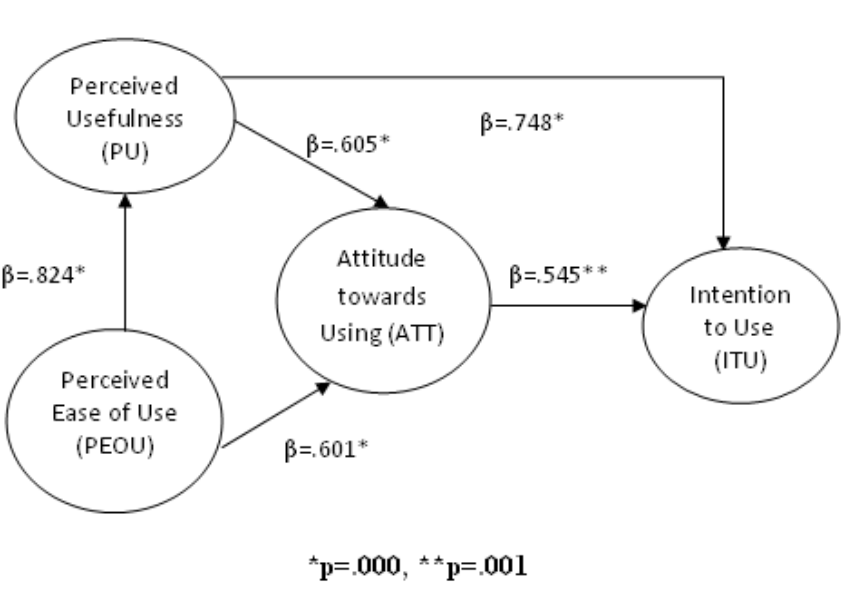
Figure 5 Final conceptual research